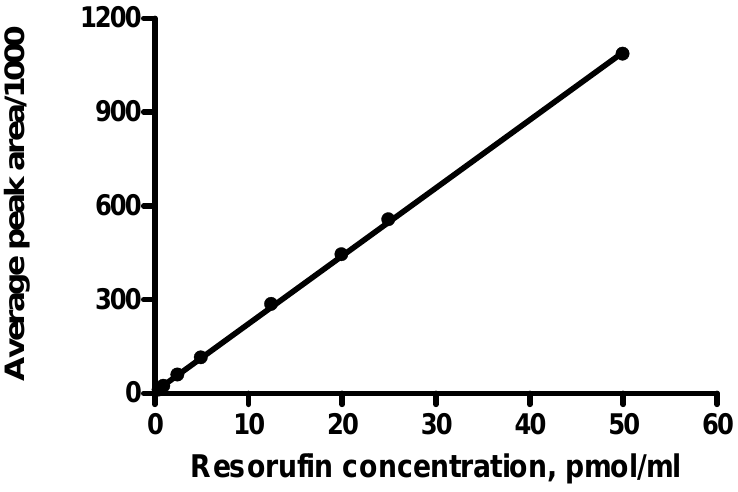
Figure 1. The standard calibration for the quantification of resorufin by HPLC (the linear regression equation for the calibration curve is y = 21.7x + 5.1; coefficient of determination is 0.9998). The fluorescence detection was performed at an excitation wavelength of 560 nm and emission wavelength of 586 nm.